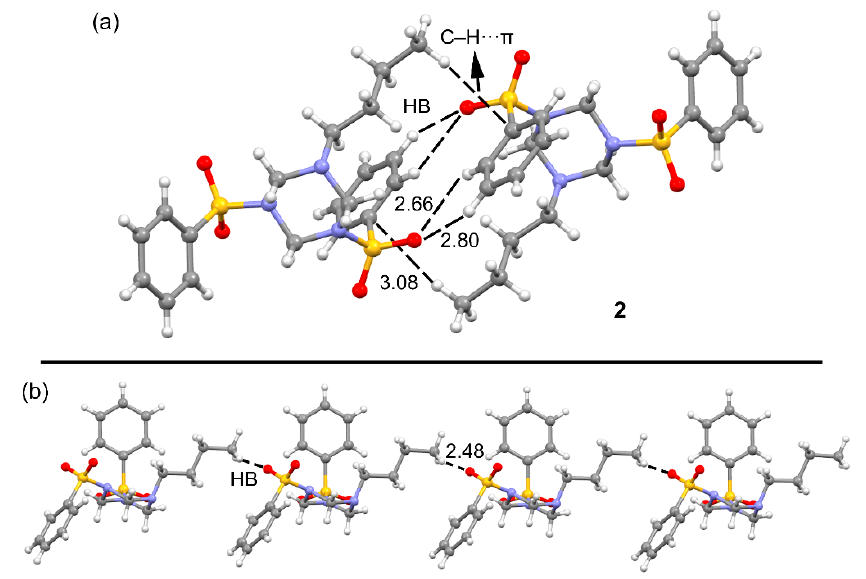
Figure 3. ( a ) Self-assembled dimer of compound 2 . ( b ) 1D supramolecular chain in 2 . Distances in Å . The C– H···π interaction distances are measured from the H -atom to the closest C-atom of the ring.